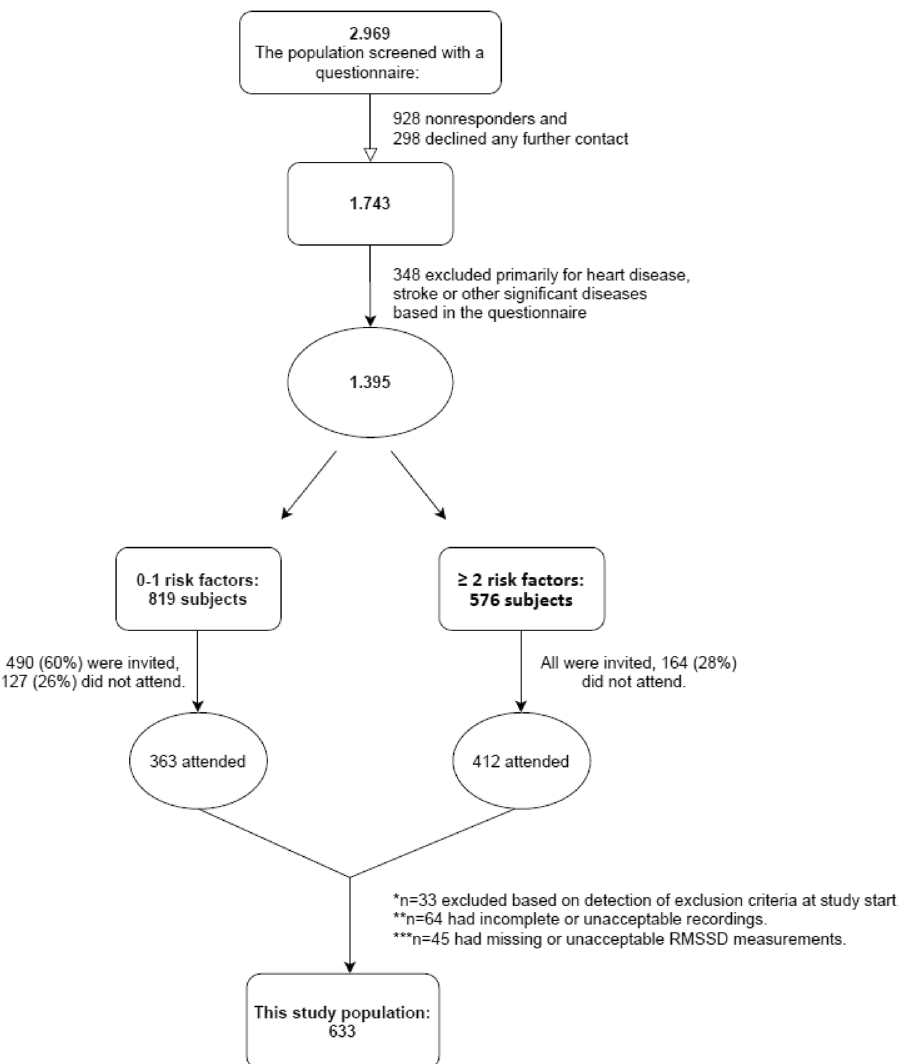
Figure 1. Flow diagram demonstrating the study population at various exclusion